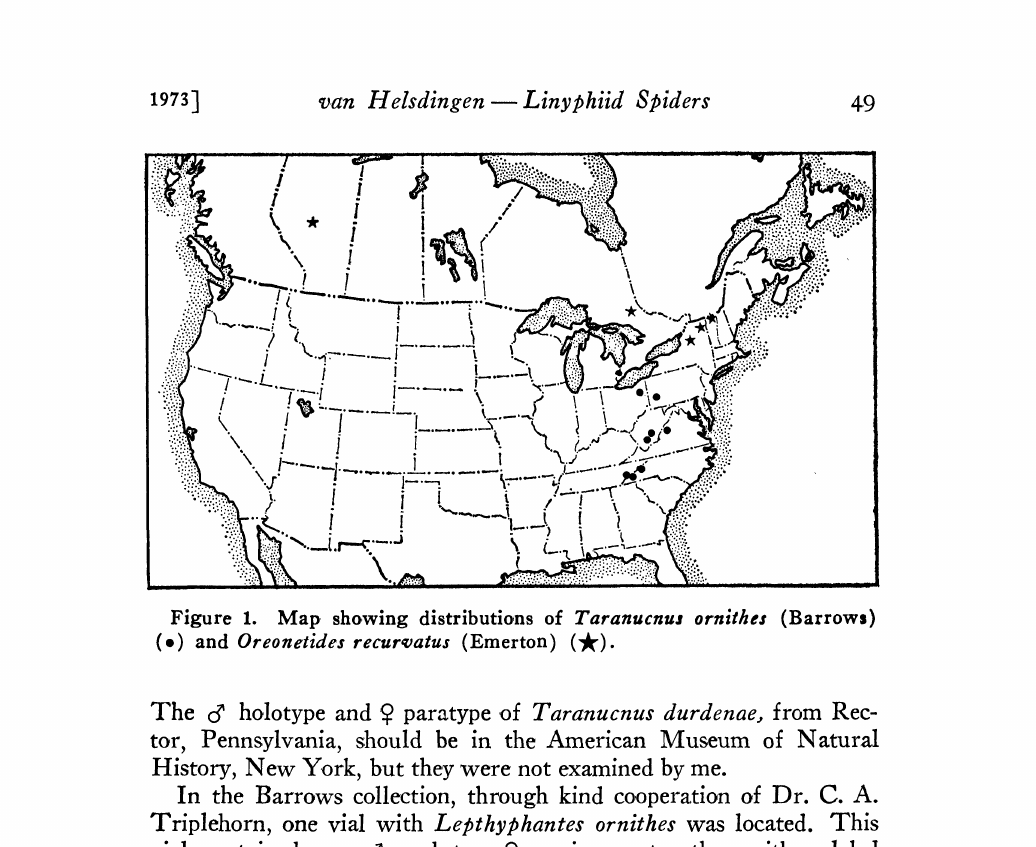
Figure 1. Map, sho,wing distributions of Taranucnu ornithes (Barrows) (o) and Oreonetides recuratus (Emerton) (’A’). The o holotype